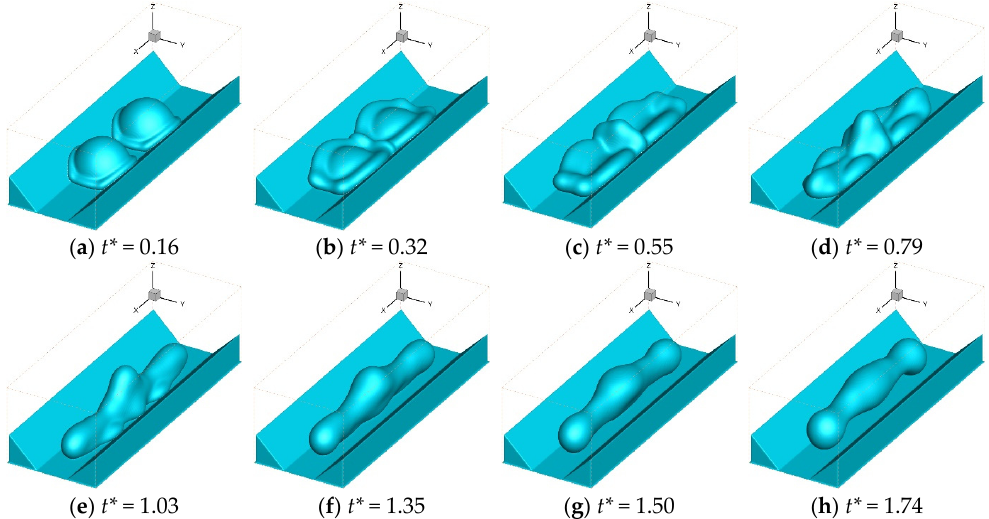
Figure 3. Snapshots of two droplets simultaneously impacting the S1 surface at L x * = 1.67 and L y * = 0.67. The morphologies at different moments are illustrated in ( a – h ).